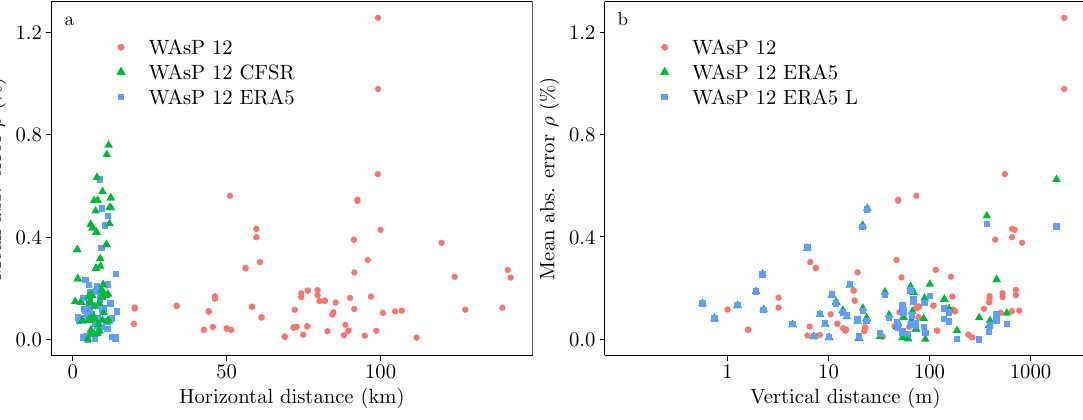
Figure 5. Scatter plot of the different modelling approaches. Note that the points from the Zugspitze station were omitted because it had a very low ρ and reduced the readability of the plot. ( a ) Mean absolute errors in estimated ρ compared to the observations as a function of horizontal distance for the models WAsP 12, WAsP 12 CFSR and WAsP 12 ERA (see section 3); ( b ) As panel ( a ), but instead as a function of vertical distance and using the WAsP 12, WAsP 12 ERA5 and the WAsP ERA5 L